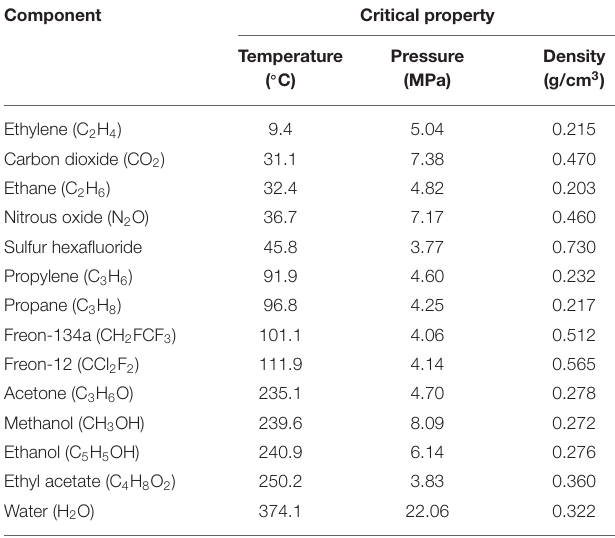
TABLE 5 | Critical properties of some pure components used in SFE (Sahena et al., 2009; Silva et al., 2016).